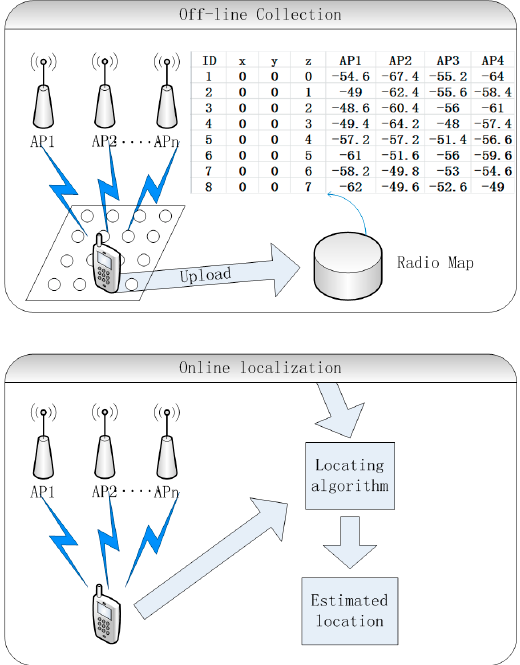
Figure 1. The workflow of a WLAN (Wireless Local Area Network) fingerprint system.